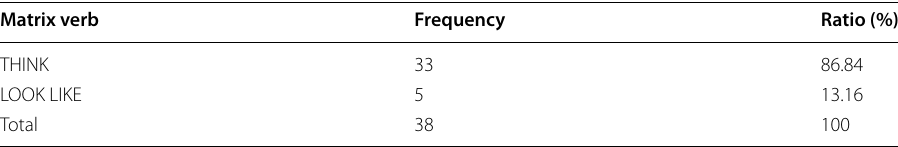
Table 4 Distribution of matrix verbs in Easson’s transferred negation Matrix